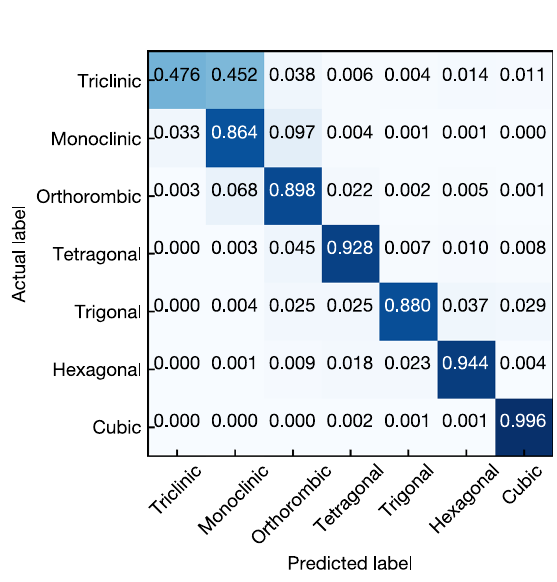
Figure 3. Confusion matrix for crystal system